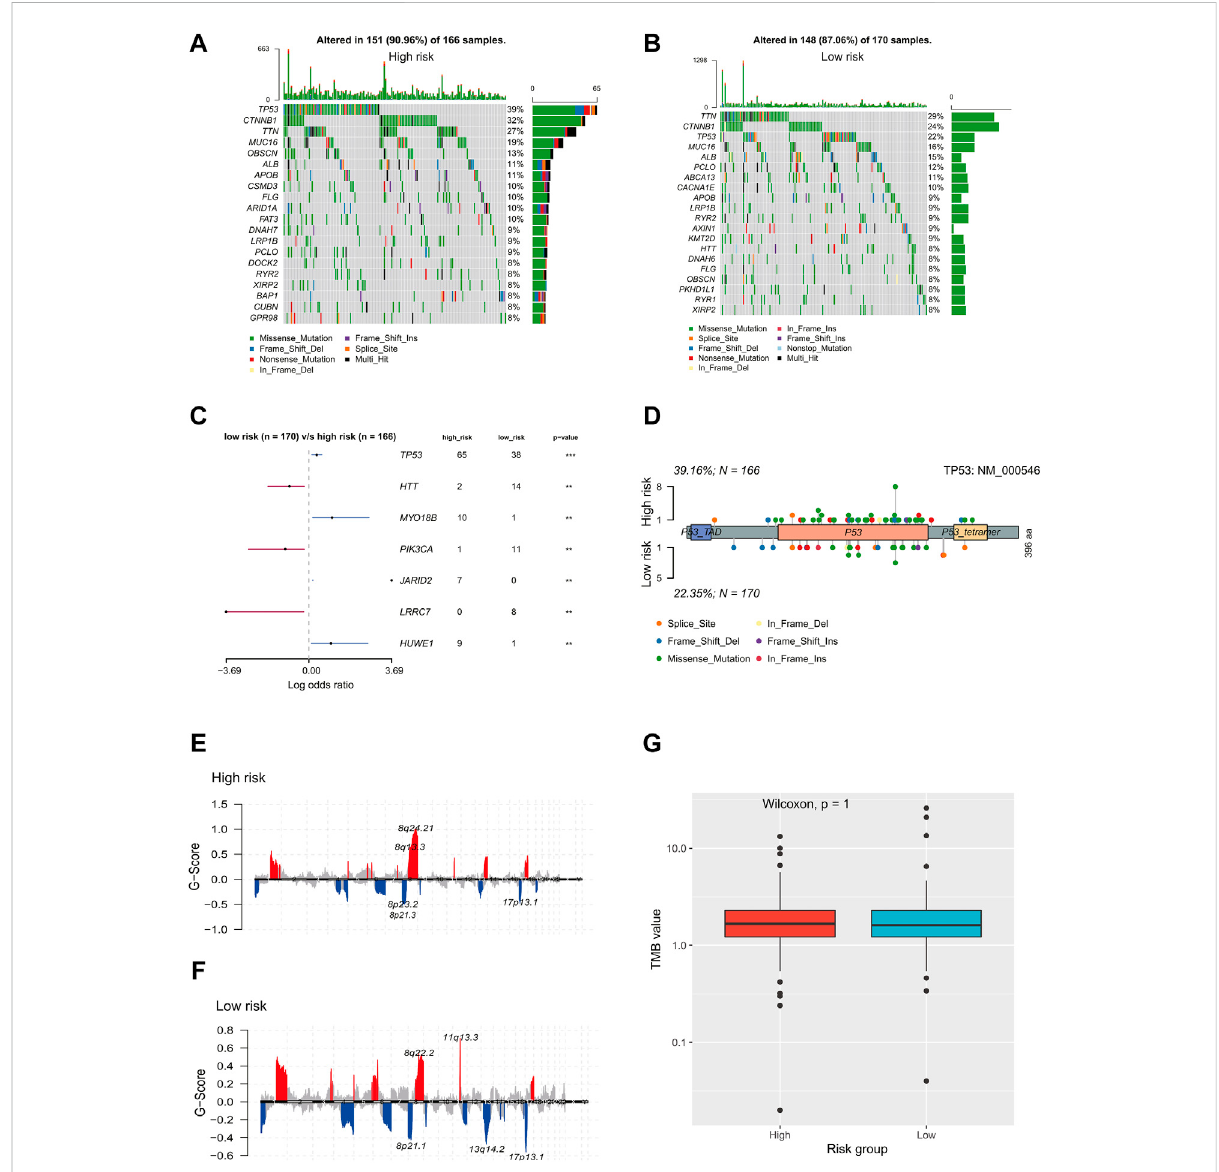
FIGURE 7 GenomiclandscapeofHCC patients inthehigh- andlow-risk group. Oncoprints showed themostprevalentaltergenes in (A) high-risk and (B) low-risk. (C) Signi fi cantly different mutated genes between low- and high-risk groups. (D) Distribution of TP53 alterations in low- and high-risk groups. (E,F) Detection and comparison of signi fi cant ampli fi cations and deletions of copy number between high- and low-risk groups. (G) Difference in the TMB values between low- and high-risk groups. HCC, hepatocellular carcinoma; TMB: tumor mutation